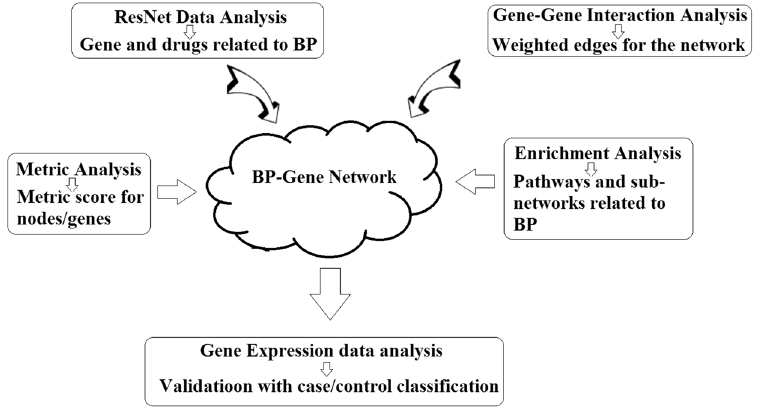
Figure 1. Diagram for the integrated computational marker evaluation